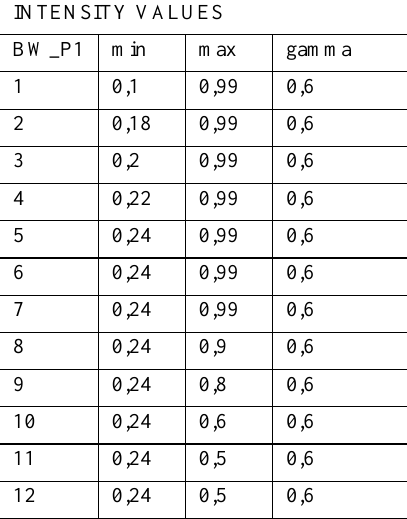
Table 2. Intensity values data tested during the post-processing in greyscale visualization (sample 1)